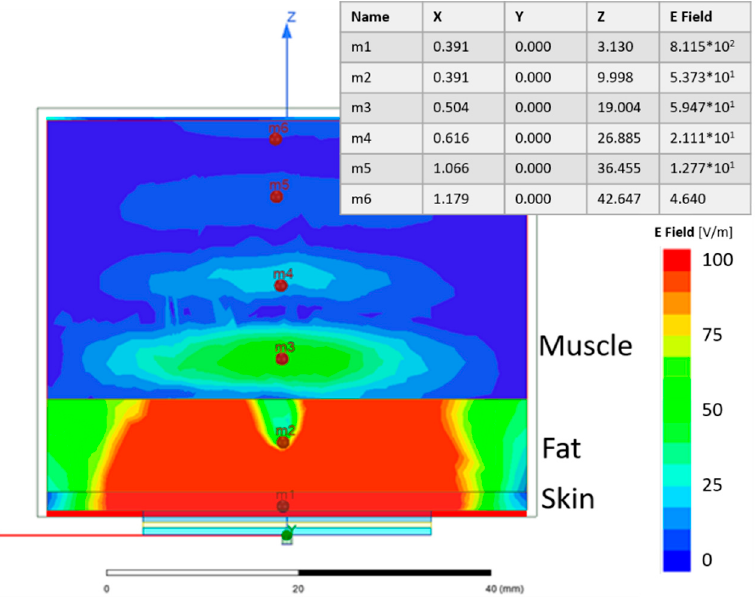
Figure 10. Electric field distribution of the SRR on a 3-layer model. The table shows the strength of the numeric values of the electric field at six selected points. For the included table X, Y and Z are given in mm and E field in V/m.